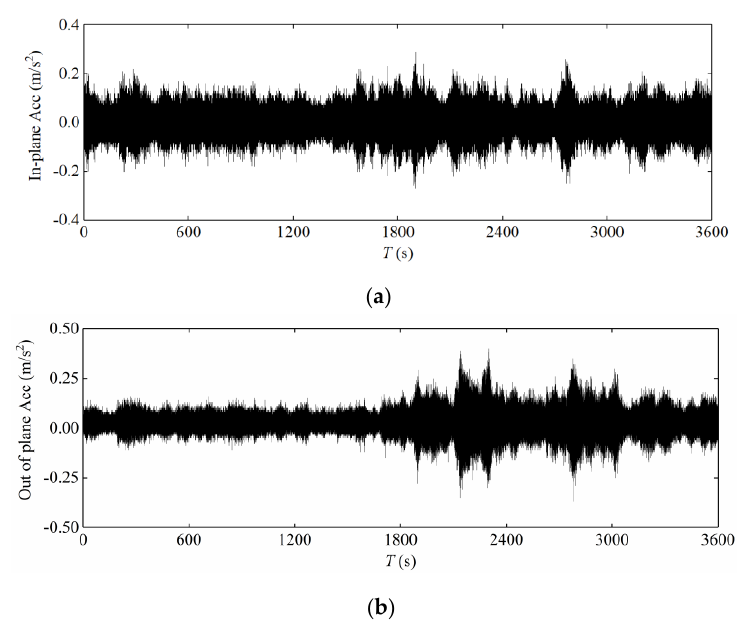
Figure 12. Measured acceleration of the downstream stay cable: ( a ) in plane; ( b ) out of plane.